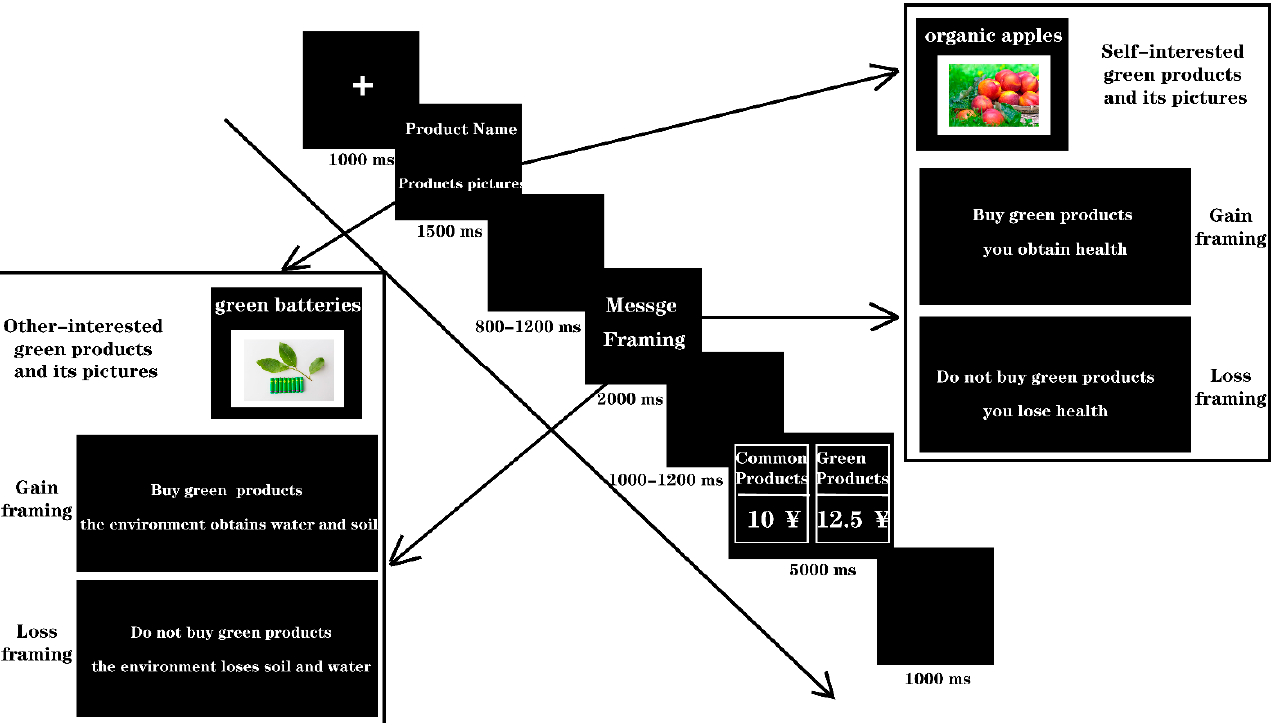
Figure 2. Illustration of a single trial of the experimental procedure.